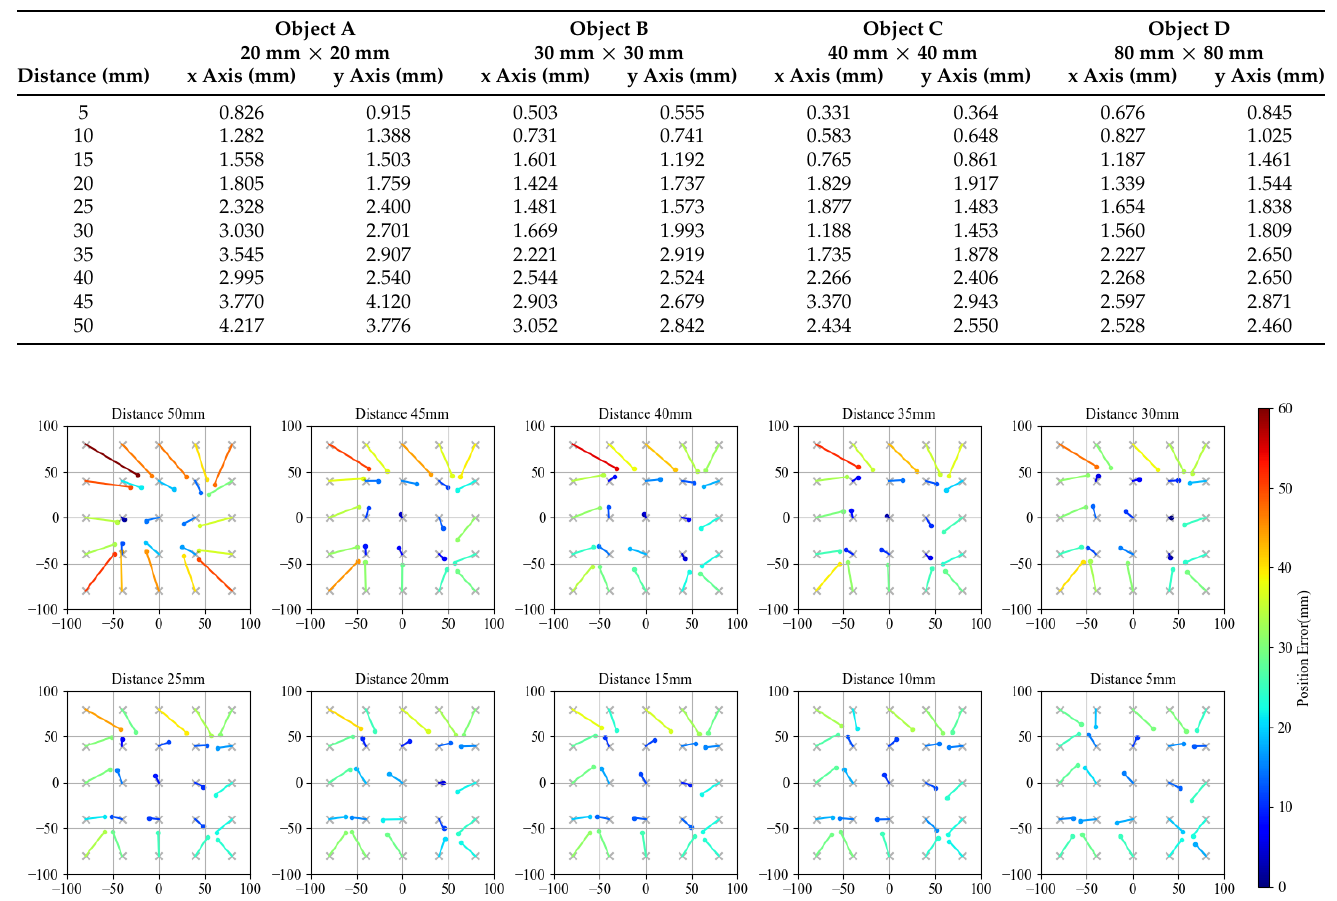
Table 3. Standard deviation (STD) of the CoP coordinates from all samples (50 frames × 25 points) at one measurement point on every height. The STD value of a single measurement point indicates the resolution of proposed sensor at the certain height.